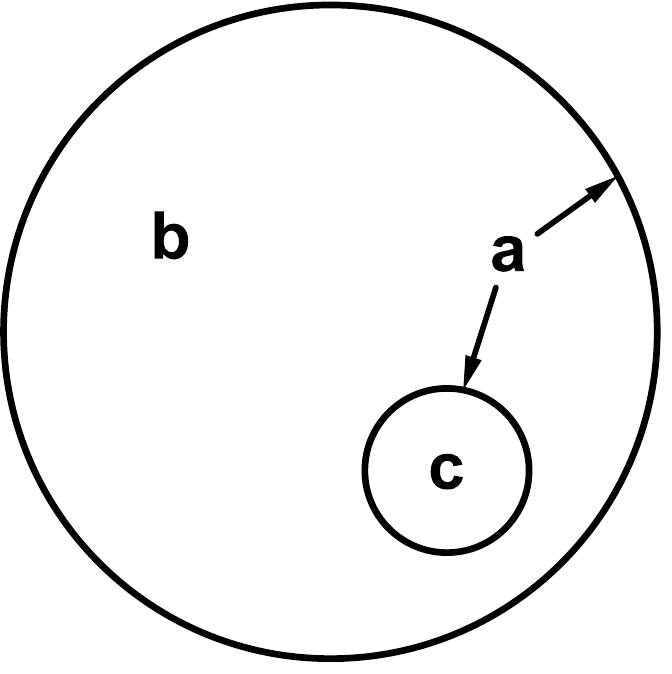
Figure 1. Highly simplified schematic of a standard mammalian cell, with bilayer membranes ( a ) surrounding the cell and the nucleus; cytoplasma ( b ); and a nucleus ( c